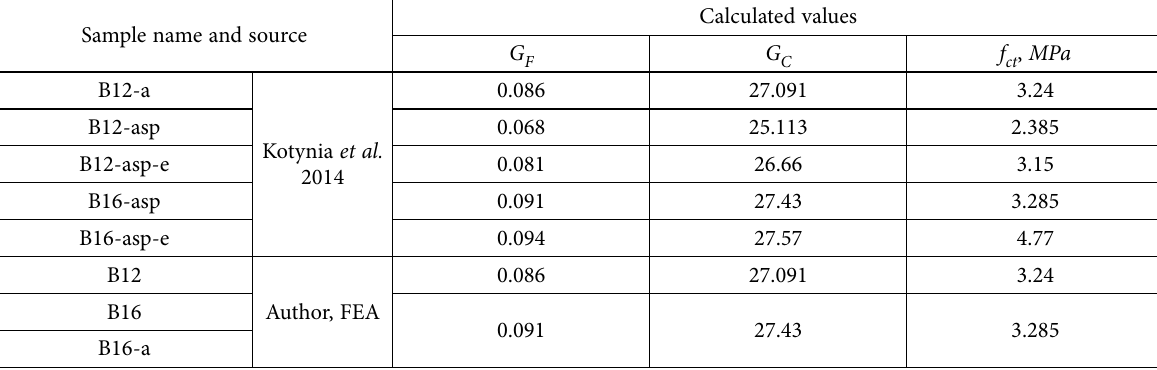
Table 3. Parameters of materials for nonlinear analysis